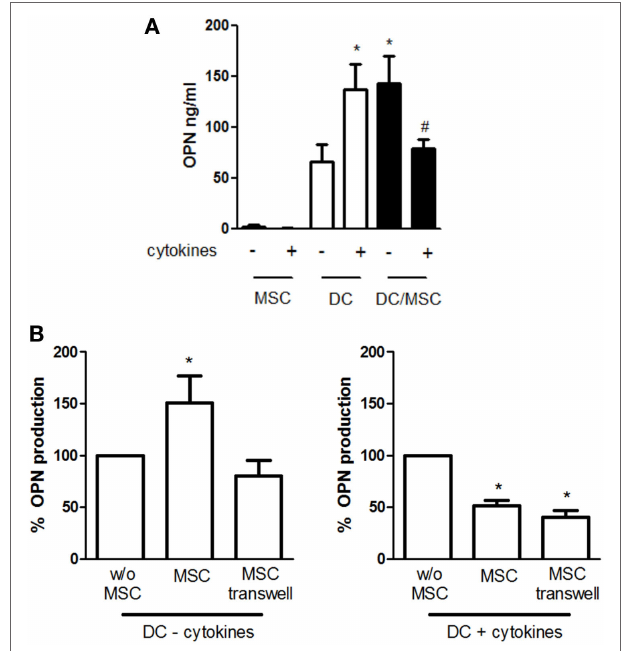
FigUre 1 | Influence of mesenchymal stromal cells (MSCs) on osteopontin (OPN) production by dendritic cells (DCs). (a) DCs were cultured alone or with MSCs (ratio DC/MSC 5:1) in the absence or in the presence of the proinflammatory cytokines (IL-1 β , TNF- α , IL-6) for 24 h and OPN levels was determined in the supernatants by ELISA. Results are expressed as mean ± SEM of 10 independent experiments. * p < 0.05 vs. DCs alone in resting conditions # p < 0.05 vs. DC/MSC coculture in resting conditions and vs. DCs alone in presence of cytokines by Student’s t -test. (B) DCs were cultured without MSCs or with MSCs in contact or in transwell systems for 24 h in resting conditions (left panel) or in presence of proinflammatory cytokines (right panel). Tested ratio were DC/MSC 5:1. OPN levels were measured by ELISA and expressed as % of OPN production by DCs alone set as 100% (mean ± SEM of five independent experiments). * p < 0.05 vs. DCs alone by Student’s t